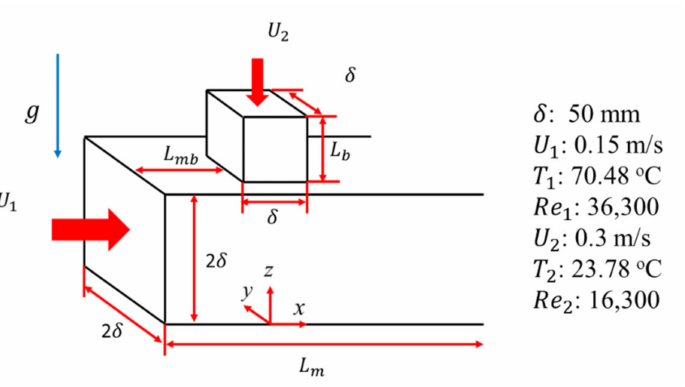
Figure 6. Geometry and flow conditions of the adopted T-junction mixing case.